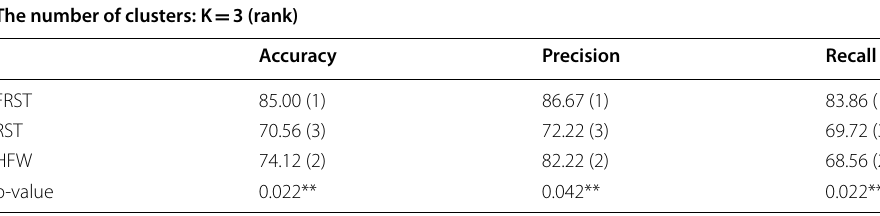
* , **, *** p < 0.1, 0.05, 0.001, respectively